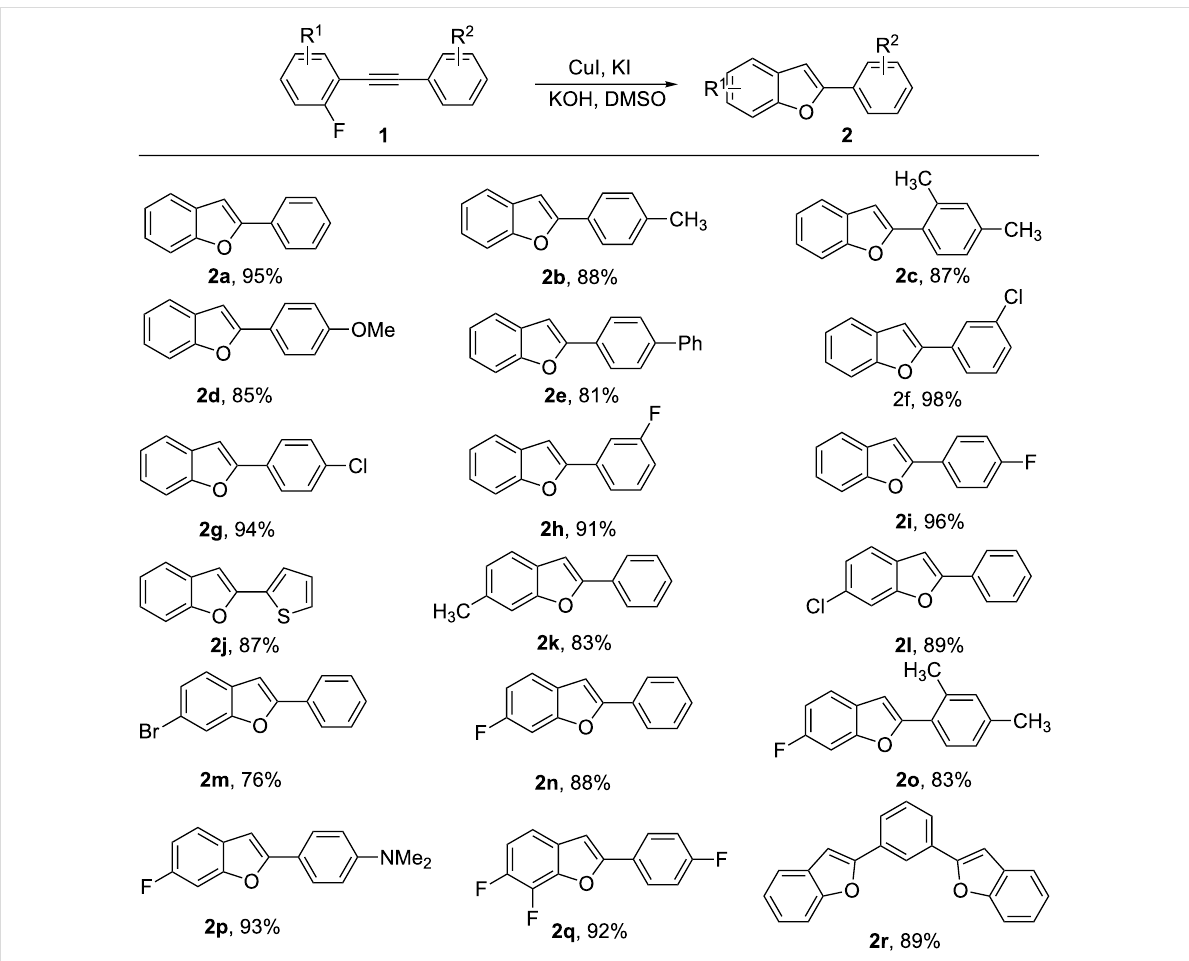
Scheme 2: Copper-promoted reaction of 2-fluorophenylacetylene derivatives to yield benzo[ b ]furans. Reaction conditions: Alkyne 1a (1.0 mmol), catalyst (10 mol %), KOH (2.0 mmol), H 2 O (1.5 mmol) and KI (0.2 mmol) in 3 mL of DMSO at 80 °C for 4–8 h; yields are given for isolated products.